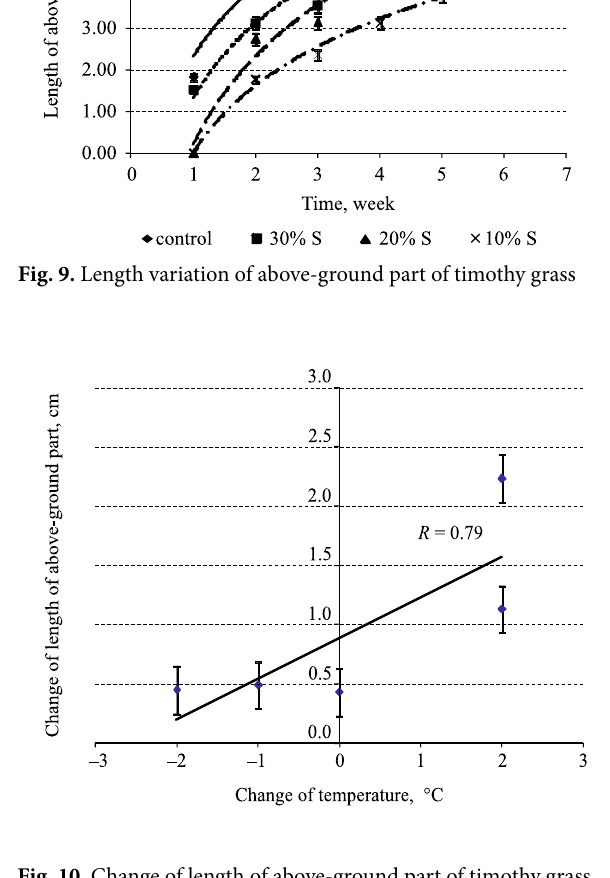
Fig. 10. Change of length of above-ground part of timothy grass dependence on change of temperature